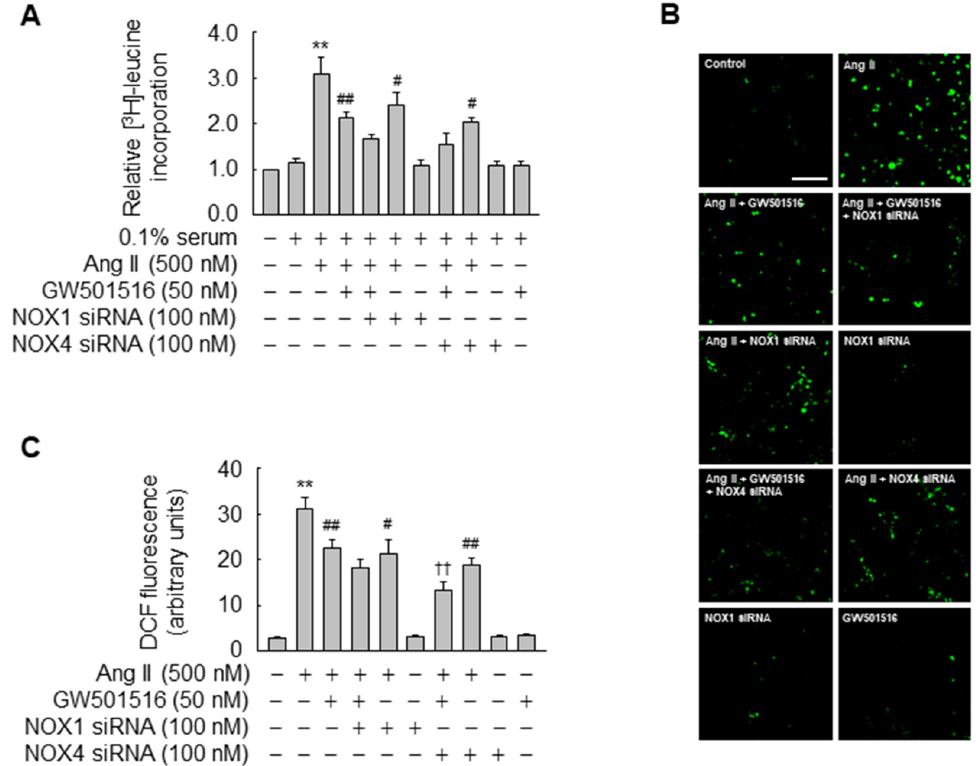
Fig 3. NOX is involved in the effects of GW501516 on VSMCs. (A) VSMCs transfected with siRNA against NOX1 or NOX4 for 48 h were pretreated with GW501516 for 24 h in DMEM containing 0.1% FBS. Thereafter, cells were treated with Ang II for 24 h and pulsed with 1 μ Ci/mL [ 3 H]-leucine for the final 6 h. (B) VSMCs transfected with siRNA against NOX1 or NOX4 for 48 h were incubated in the presence or absence of GW501516 for 24 h and then exposed to Ang II for 24 h. Intracellular ROS were detected by confocal laser fluorescence microscopy using the peroxide-sensitive dye CM-H 2 DCF-DA (10 μ M, B), and the fluorescence intensity was quantified (C). Data represent means ± SE (n = 5). Bars, 200 μ m. �� p < 0.01 compared with the untreated group; ## p < 0.01, # p < 0.05 compared with the Ang II-treated group; and †† p < 0.01 compared with the Ang II plus GW501516-treated